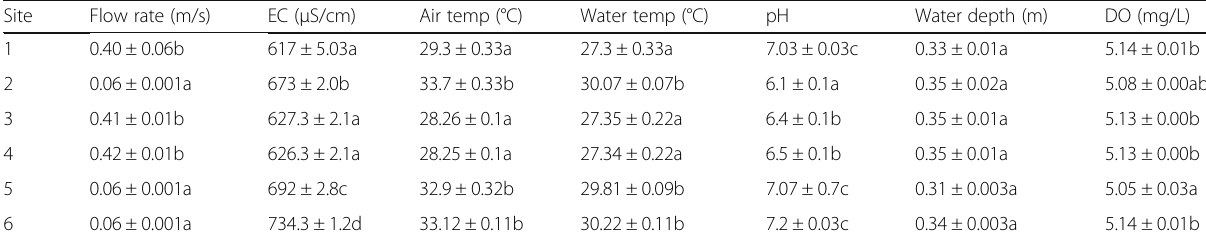
Table 2 The physico-chemical parameters of the six study sites at Aahoo stream, Akure, Nigeria